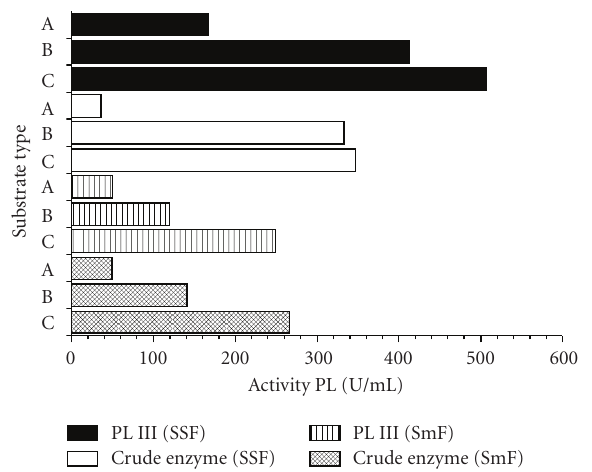
Figure 6: Substrate specificity of crude enzyme and P LIII produced by P. viridicatum RFC3 in solid-state (SSF) and submerged fermentation (SmF): (A) = 92%-esterified citrus pectin (Sigma); (B) = 26%-esterified citrus pectin (Sigma); and (C) = Polygalacturonic acid.